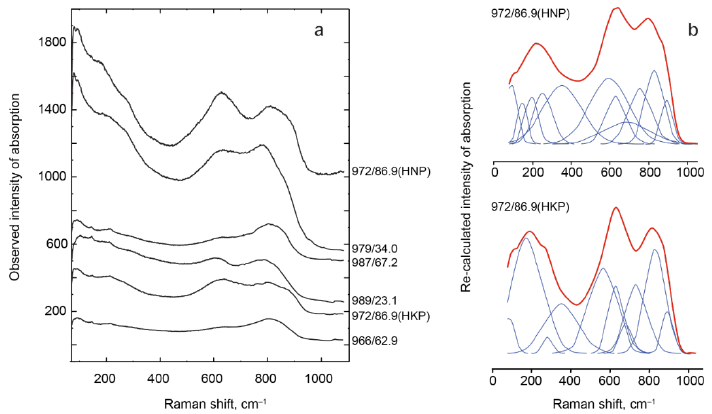
Figure 11. Initial ( a ) and re-calculated ( b ) Raman spectra of pyrochlore supergroup minerals. HNP is hydroxynatropyrochlore, HKP is hydroxykenopyrochlore.